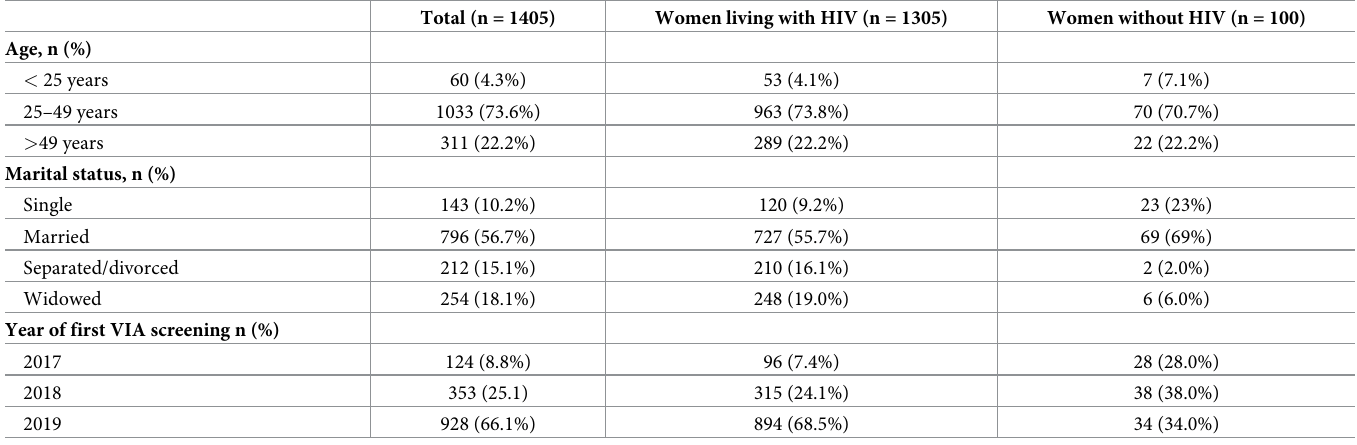
Table 1. Characteristics of women undergoing first-time VIA, total and by HIV